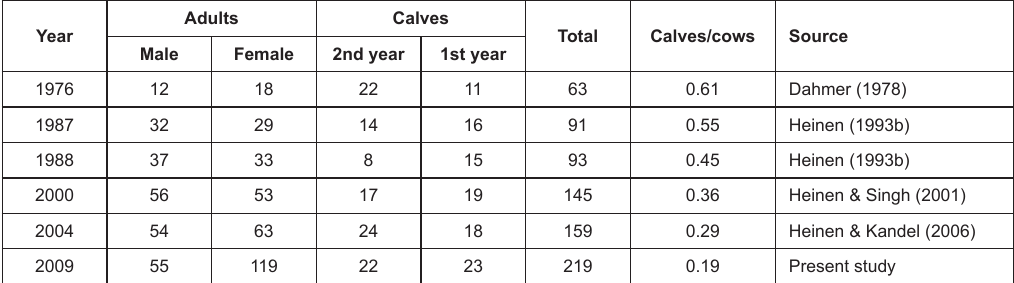
Table 2. The population structure of wild buffalo in KTWR from 1976 to 2009, with the calf to cow ratio